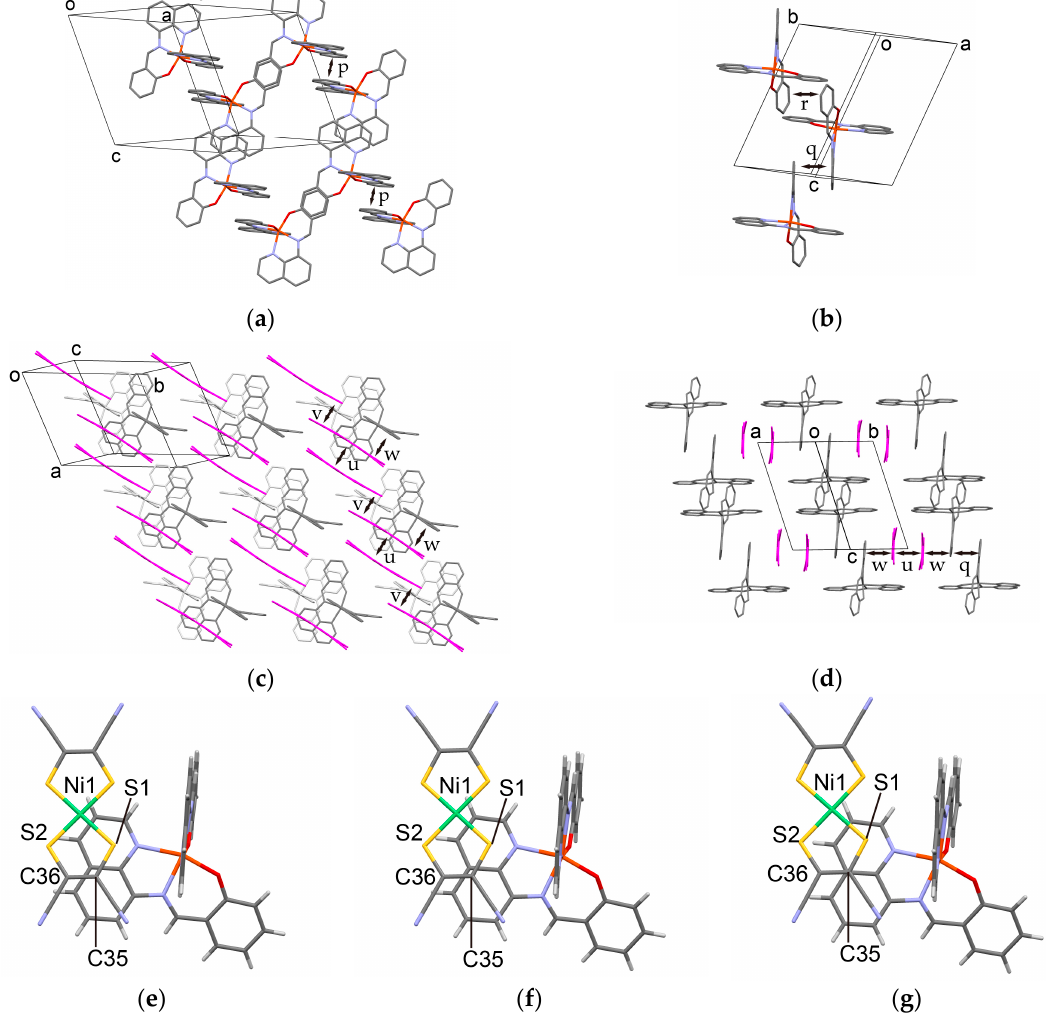
Figure 4. Crystal structure of 1 . ( a ) 2D molecular arrangement of the [Fe(qsal) 2 ] moleucle viewed along the direction perpendicular to the overlapped quinolyl plane at 293 K; ( b ) π -stacking mode between the [Fe(qsal) 2 ] dimers viewed along the direction parallel to the overlapped quinolyl plane at 293 K; ( c ) Molecular arrangement of the [Ni(mnt) 2 ] molecule (magenta sticks) along with the [Fe(qsal) 2 ] molecule layer just below the [Ni(mnt) 2 ] layer at 293 K; ( d ) Side view of π -stacking structure from the [Ni(mnt) 2 ] dimer and quinolyl rings perpendicular to the a – b direction at 293 K; Top views of the π -stacking between the [Ni(mnt) 2 ] and nonplanar qsal molecules at 293 K ( e ); at 100 K ( f ); at 25 K ( g );. Letters with double-headed arrows indicate the positions listed in Tables 4 and